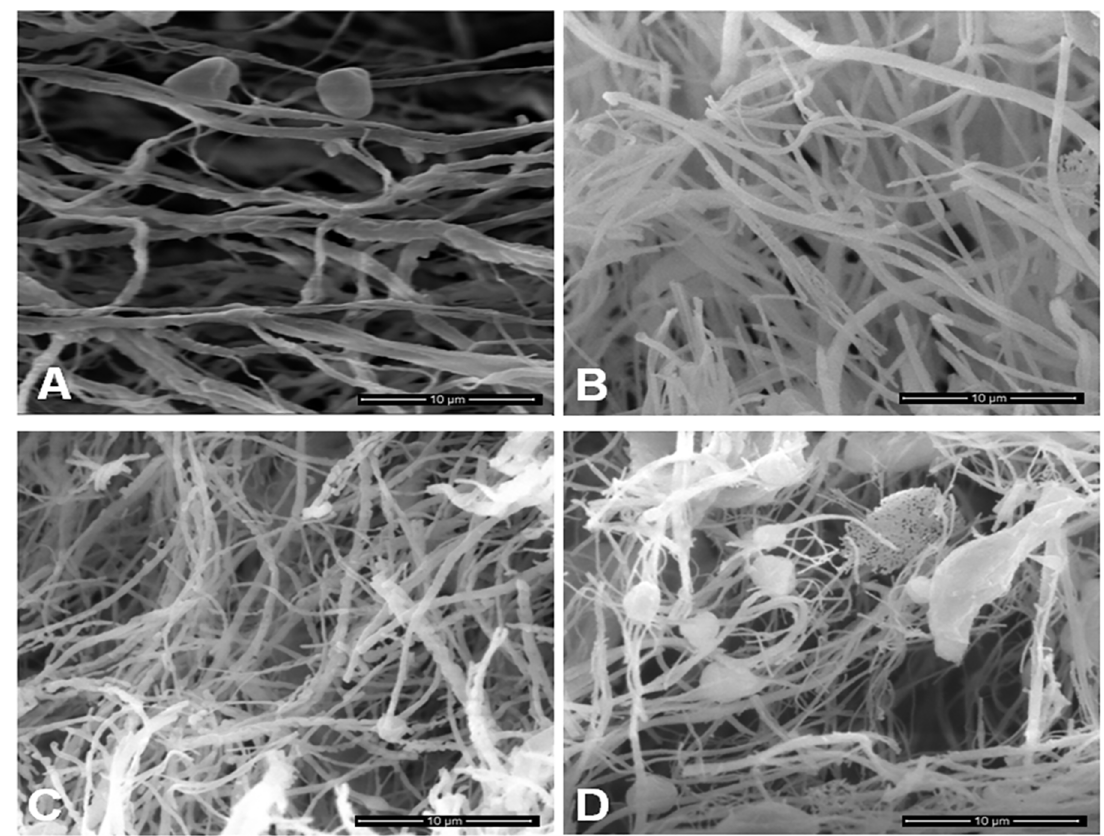
Figure 5. SEM micrographs of the spun fibers A - A1-1000, B - A1-900, C A075-1000, D - A075-900.